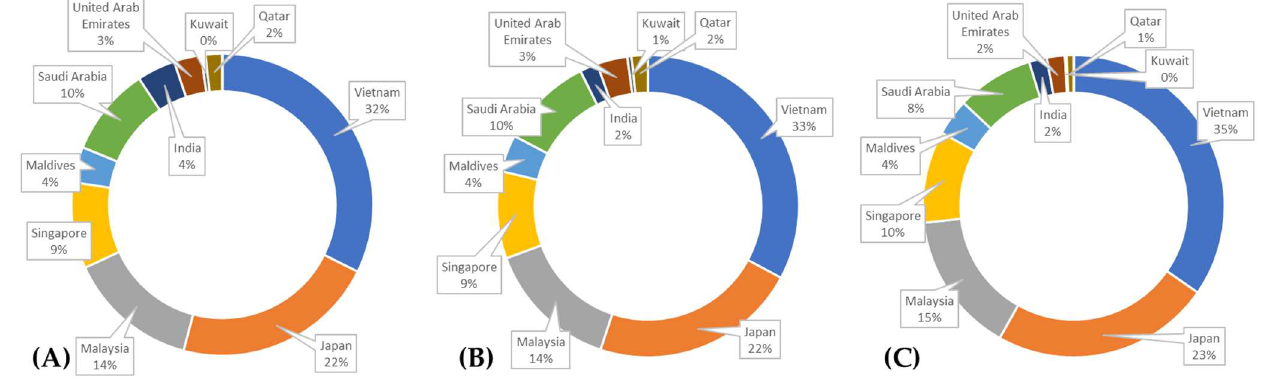
Figure 14. Top ten countries importing from Sri Lanka during 2010–2020: ( A ) total quantities, ( B ) virtual water, ( C ) virtual land for top nine crops.